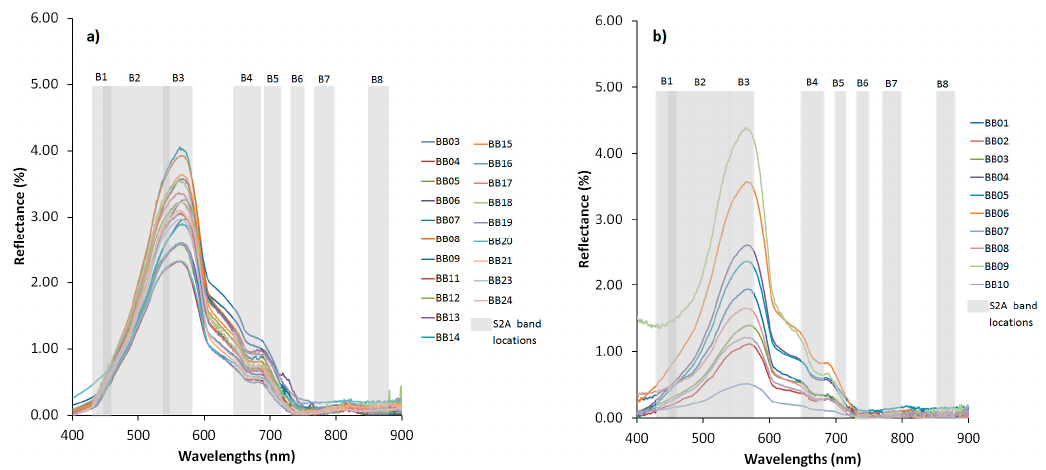
Figure 2. Reflectance spectra curves of water sampling points over Lake Ba Be measured on 4 May 2017 ( a ) and 26 June 2016 ( b ) overlaid with S2A visible to NIR bands (band 1: B1 to 8a: B8a) locations showing the coincidences of the S2A green and red bands to the peak and trough of the water reflectances, respectively.